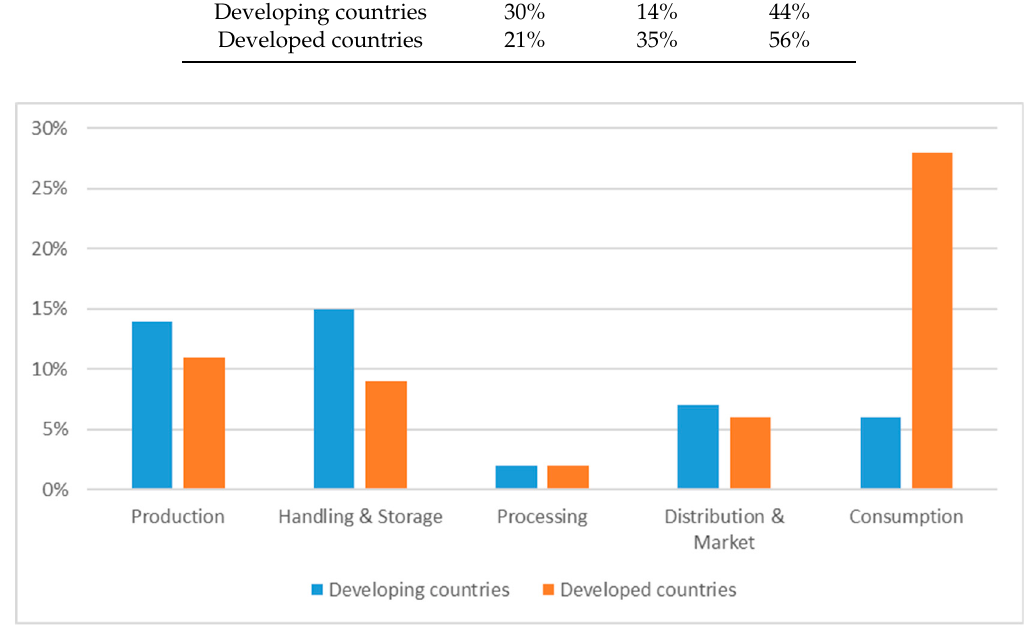
Figure 2. Portion of FLW in the stages of the food supply chain (FSC). Source: Lipinski et al. [6].